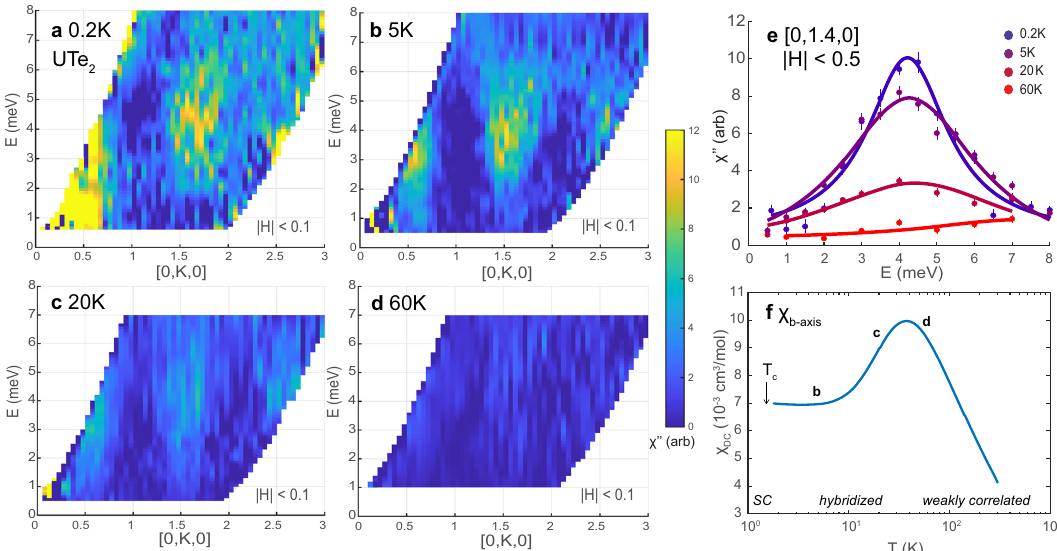
Fig. 3 Temperature dependence of the magnetic susceptibility in UTe 2 . χ ″ ( Q , E ) as a function of K at the BZ edge at ( a ) 0.2 K in the superconducting state, at ( b ) 5 K in the strongly hybridized, renormalized Fermi liquid state, at ( c ) 20 K where hybridization is weaker, and ( d ) at 60 K where correlations between local f electrons and light bands are weakest. e As temperature increases, the total spectral weight decreases but the magnetic susceptibility remains peaked at the same q value until it is no longer detectable above background. f This behavior follows closely the temperature-dependence of the bulk magnetic susceptibility χ along the b-axis (K direction) 1 , which shows a hump structure characteristic of heavy fermion Kondo lattices (1 cm 3 mol − 1 = 4 π × 10 − 6 m 3 mol − 1 ). The letters indicate the temperatures of the corresponding neutron data. Error bars correspond to an uncertainty of one standard